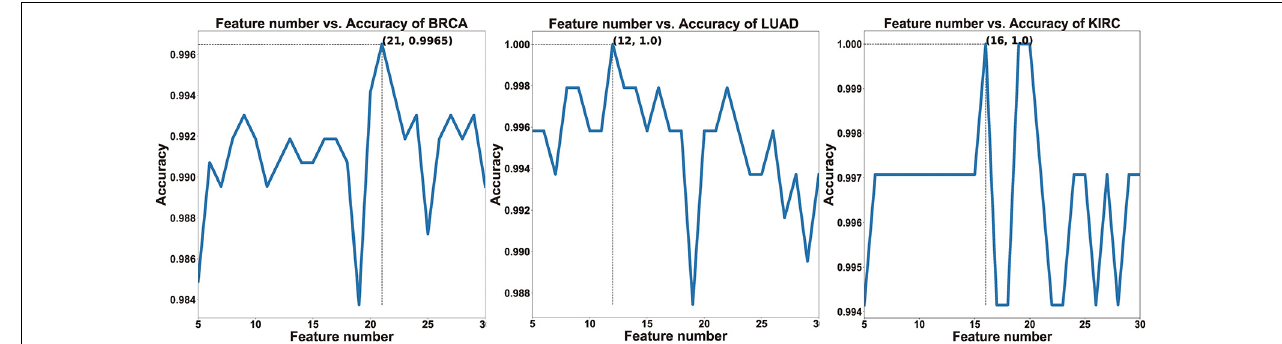
FIGURE 3 | The relationship curves of the features and the accuracy of three cancers.